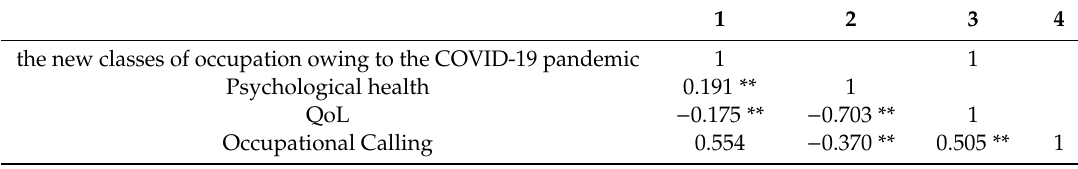
Table 3. Correlations between COVID-19 new occupational class, calling, psychological health, and QoL ( N = 1029).